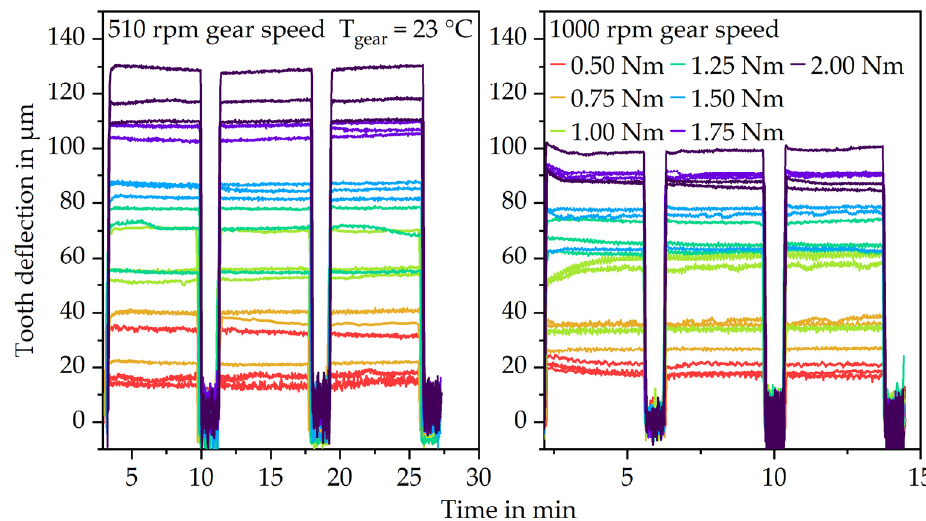
Figure 7. Results for the elastic tooth bending (gear test runs).